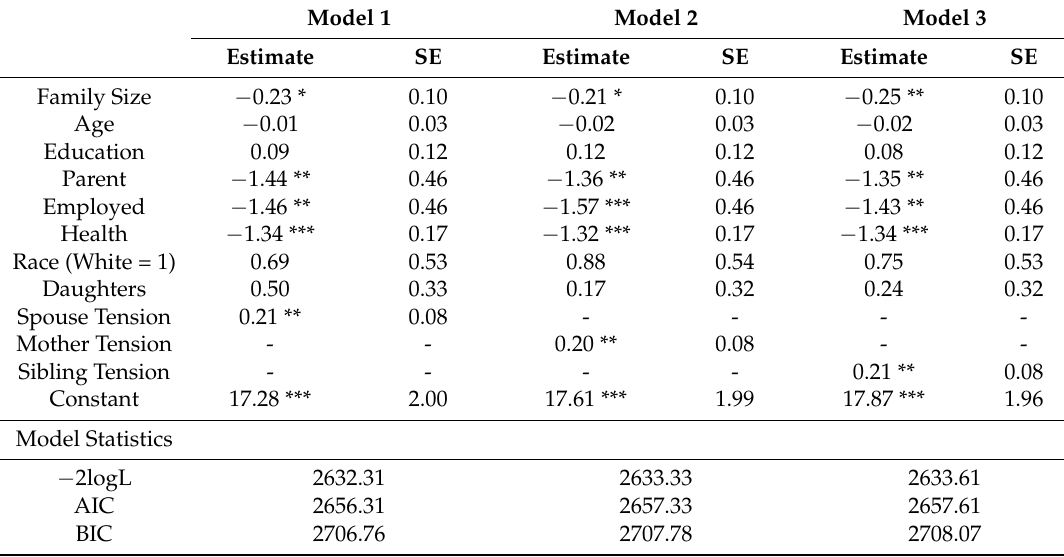
Table 3. Mixed Model Results Predicting Depressive Symptoms with Tension (N =